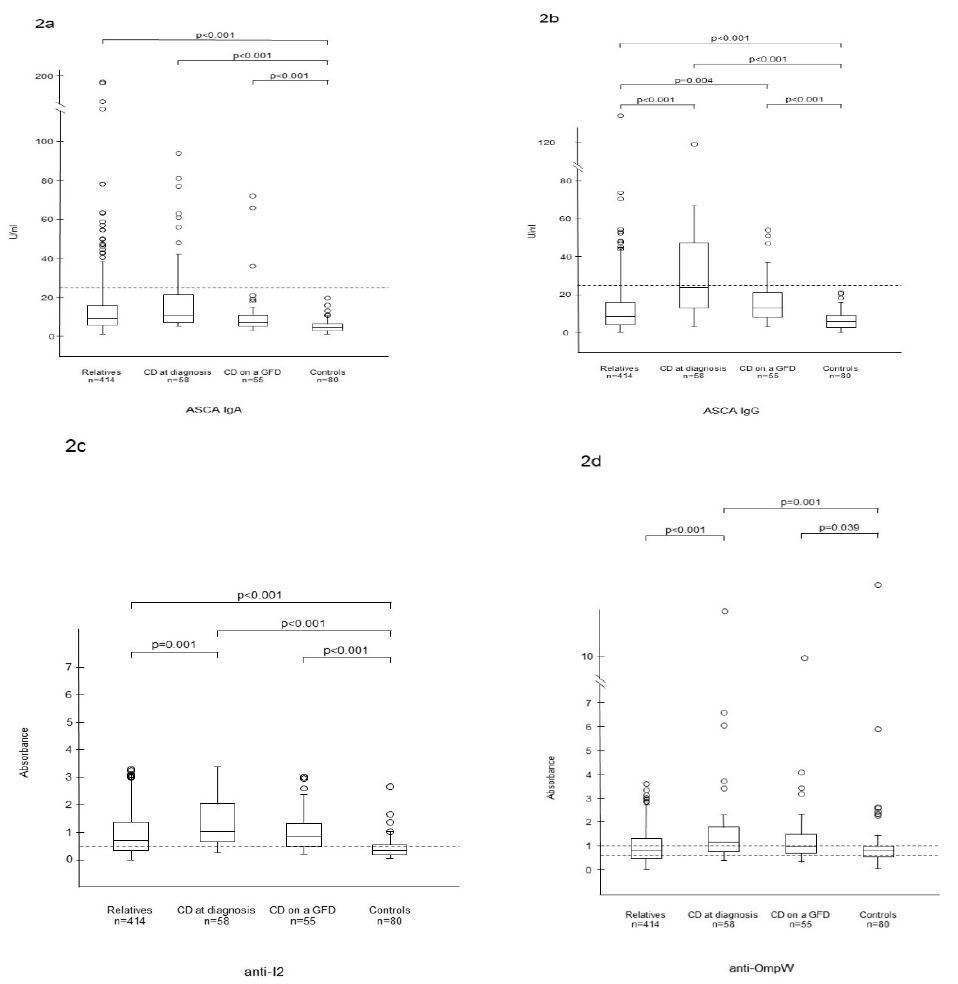
Figure 2. Serum levels of antibodies to Saccharomyces cerevisiae (ASCA) in IgA ( a ) and IgG ( b ) classes, Pseudomonas fluorescens -associated sequence (anti-I2) ( c ) and Bacteroides caccae TonB-linked outer membrane protein (anti-OmpW) ( d ) in autoantibody-negative relatives. Horizontal lines indicate the cutoff level for seropositivity of each antibody. Table 2. Frequency of seropositivity to microbial markers in autoantibody-negative relatives of celiac disease patients with different human leukocyte antigen (HLA) haplotypes.